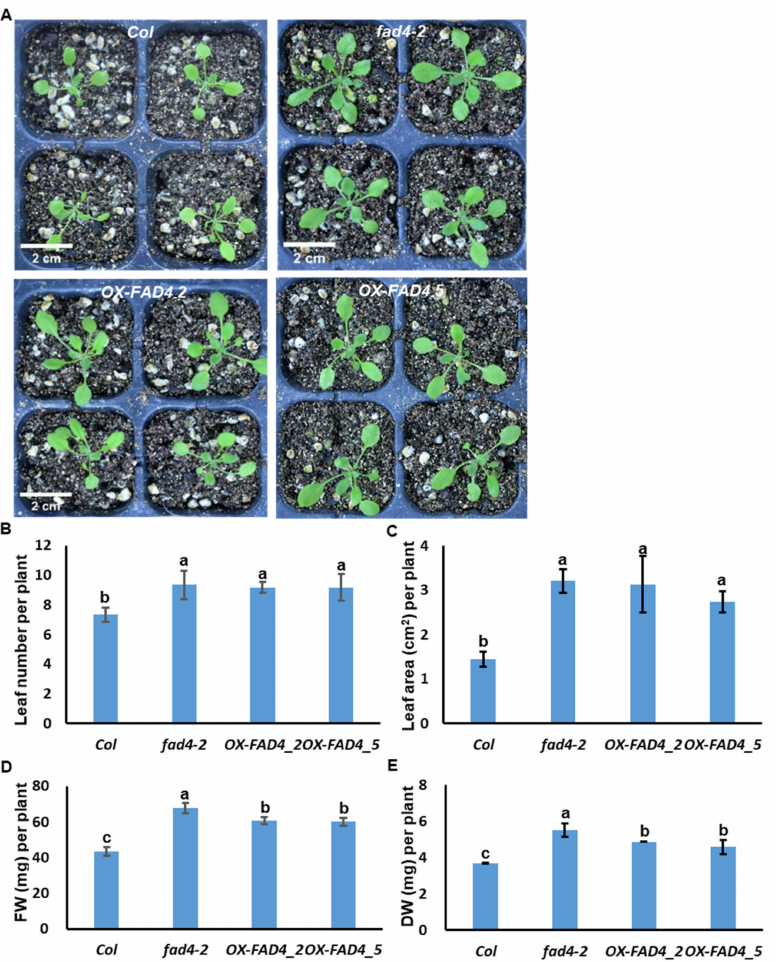
Figure 3. Overexpression or knockout of FAD4 in Arabidopsis enhanced plant growth under continu- ous light. ( A ) Photography of seedlings after grown 24 days under continuous light. ( B – E ) Average leaf number, average projected leaf area, average fresh weight, and average dry weight per plant of Col , fad4-2 , OX-FAD4_2 and OX-FAD4_5 . Data were expressed as average ± standard deviation (n = 6). Different letters indicate significant differences at p < 0.05 by one-way ANOVA with Duncan’s multiple range test. Bar = 2 cm in ( A